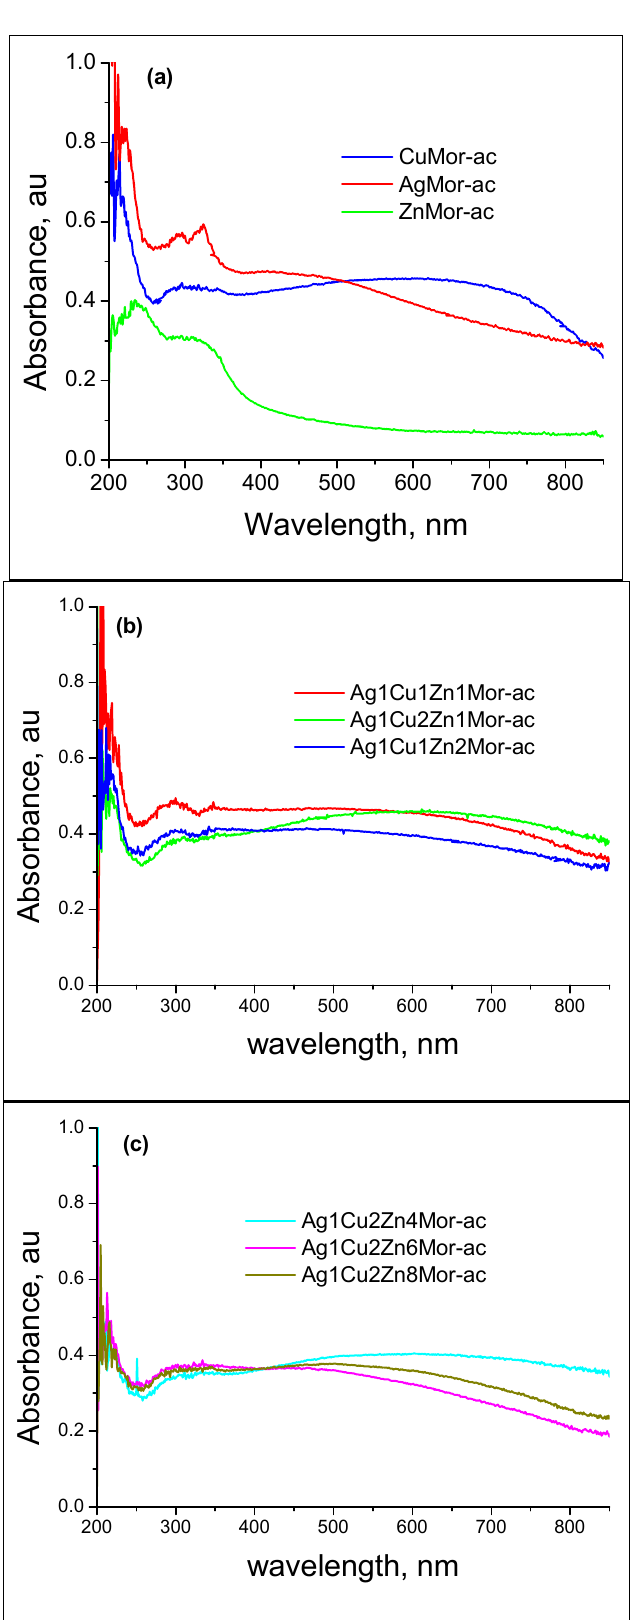
Figure 8. UV-Vis diffuse reflectance spectra of the samples reduced in hydrogen and then cooled in air.